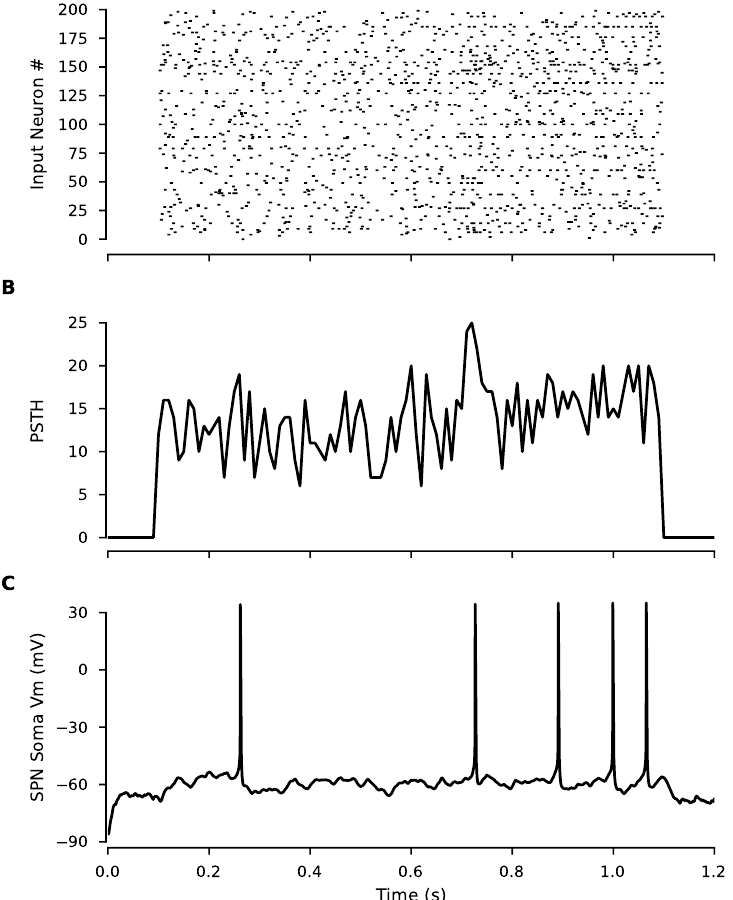
Figure 1. In vivo-like inputs constructed from cortical spike trains produce spiking in SPNs. ( A ) Raster plot shows spike times for each cortical input in the model, constructed from in vivo spike train recordings. ( B ) Peri-stimulus time histogram of the above raster plot (spike counts per 10 ms bin) ( C ) Somatic membrane potential of the SPN model showing spiking output induced by cortical input. To generate controlled trial-to-trial variability of spike timing, the initial trial was